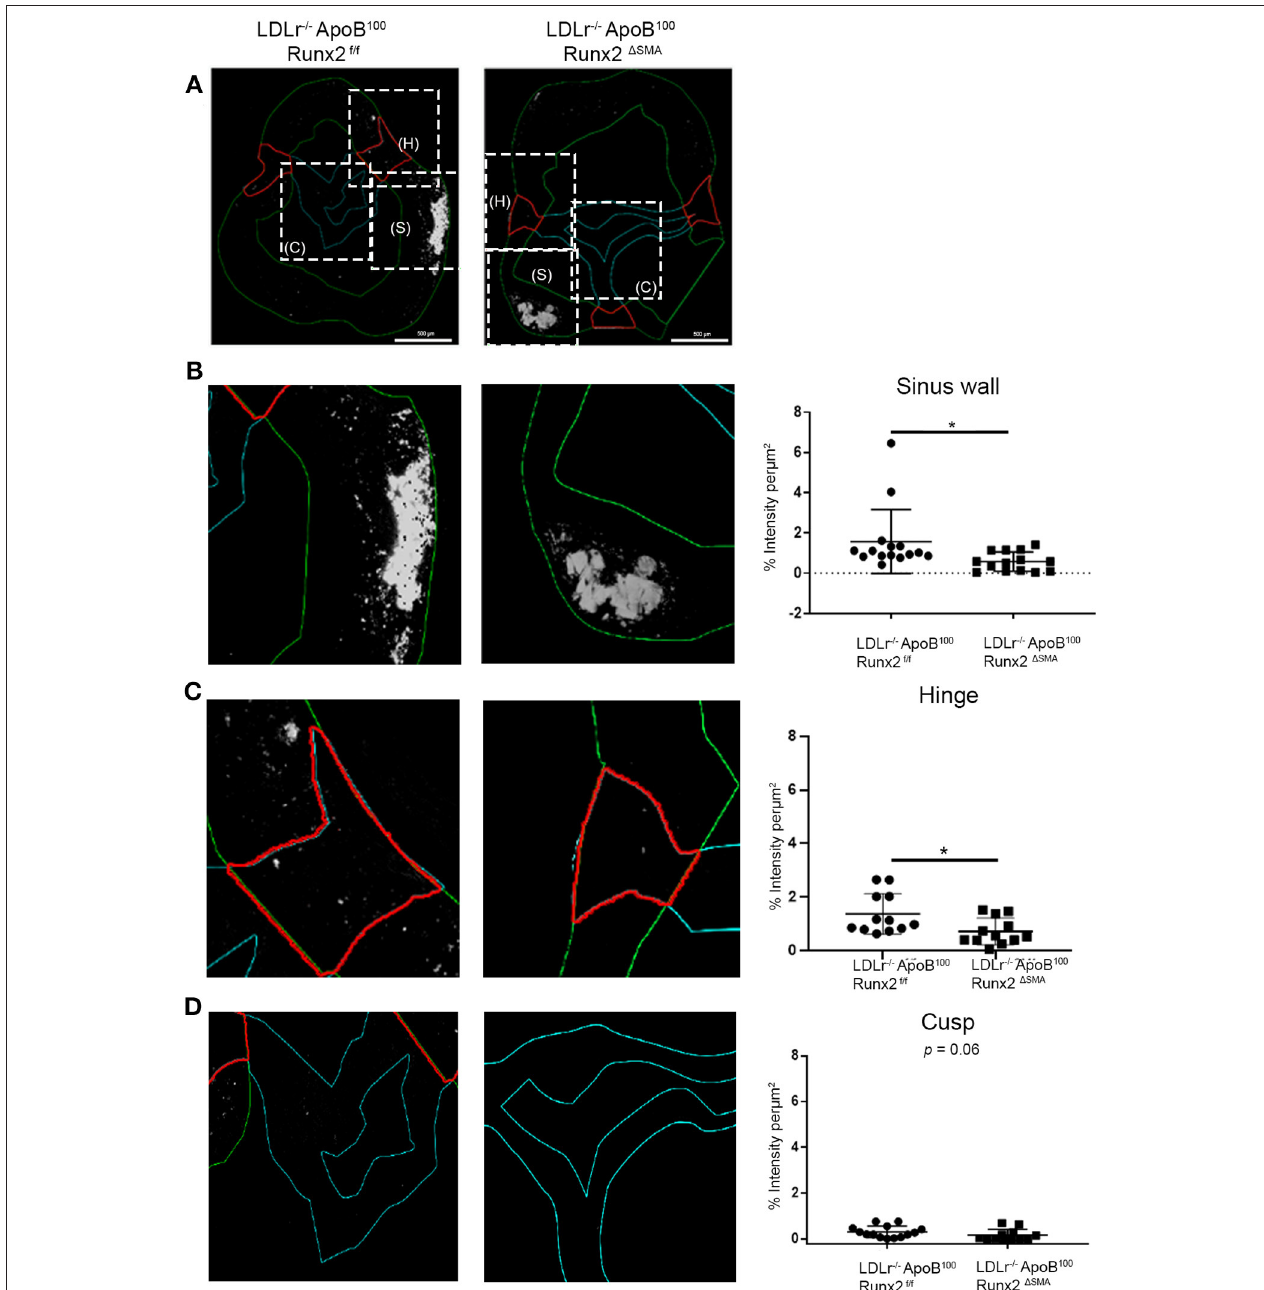
FIGURE 7 | Runx2 depletion decreased calcification in the aortic valve. (A) Representative images of valve sections labeled with osteosense from the LDLr − / − ApoB 100 Runx2 f / f and LDLr − / − ApoB 100 Runx2 1 SMA mice to assess calcification. Boxed areas (dashed lines) within (A) represent the sinus wall (green), hinge (red), and cusp (teal). Higher magnification of boxed area from (A) , representing the sinus wall (B) , hinge (C) , and cusp (D) in the aortic valve and their respective intensity quantification graphs ( n = 15 per group). The differences between groups were analyzed by Mann-Whitney non-parametric tests. * p < 0.05. Data shown are mean ±